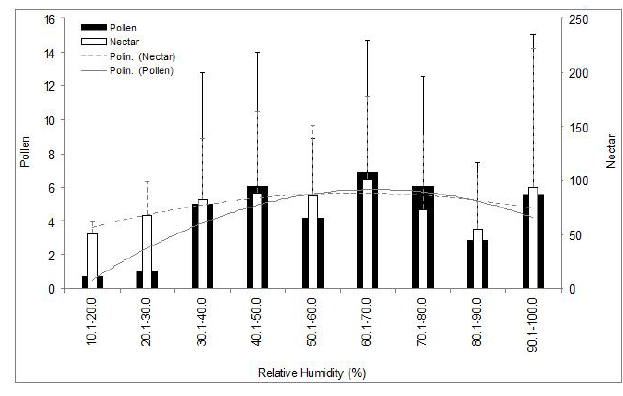
Fig 2 . Pollen and nectar collection by Melipona quadrifasciata anthidiodes related to the relative humidity intervals. Solid and dashed bars represent standard deviation of pollen and nectar collection, respectively.